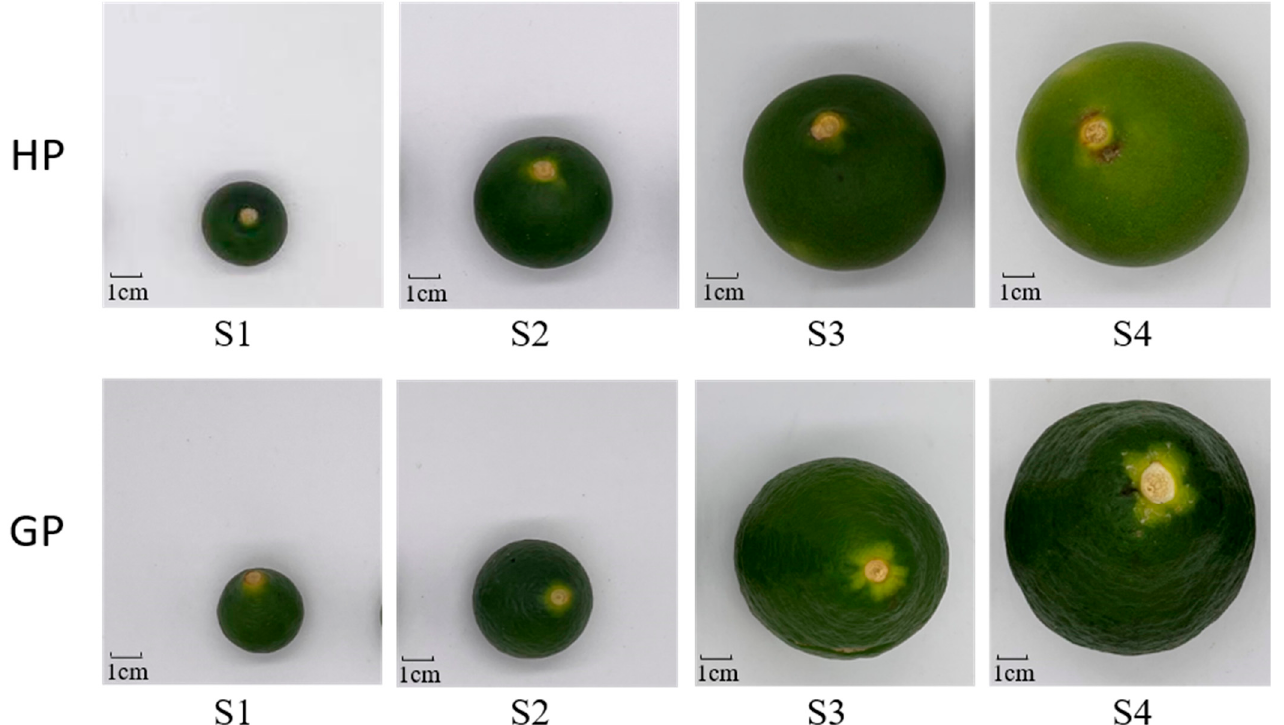
Figure 5. Pomelo fruit development stages. S1–S4 four sampled stages during fruit development. The upper fruits are “Golden pomelo” (GP) and the down fruits are “Honey pomelo” (HP).